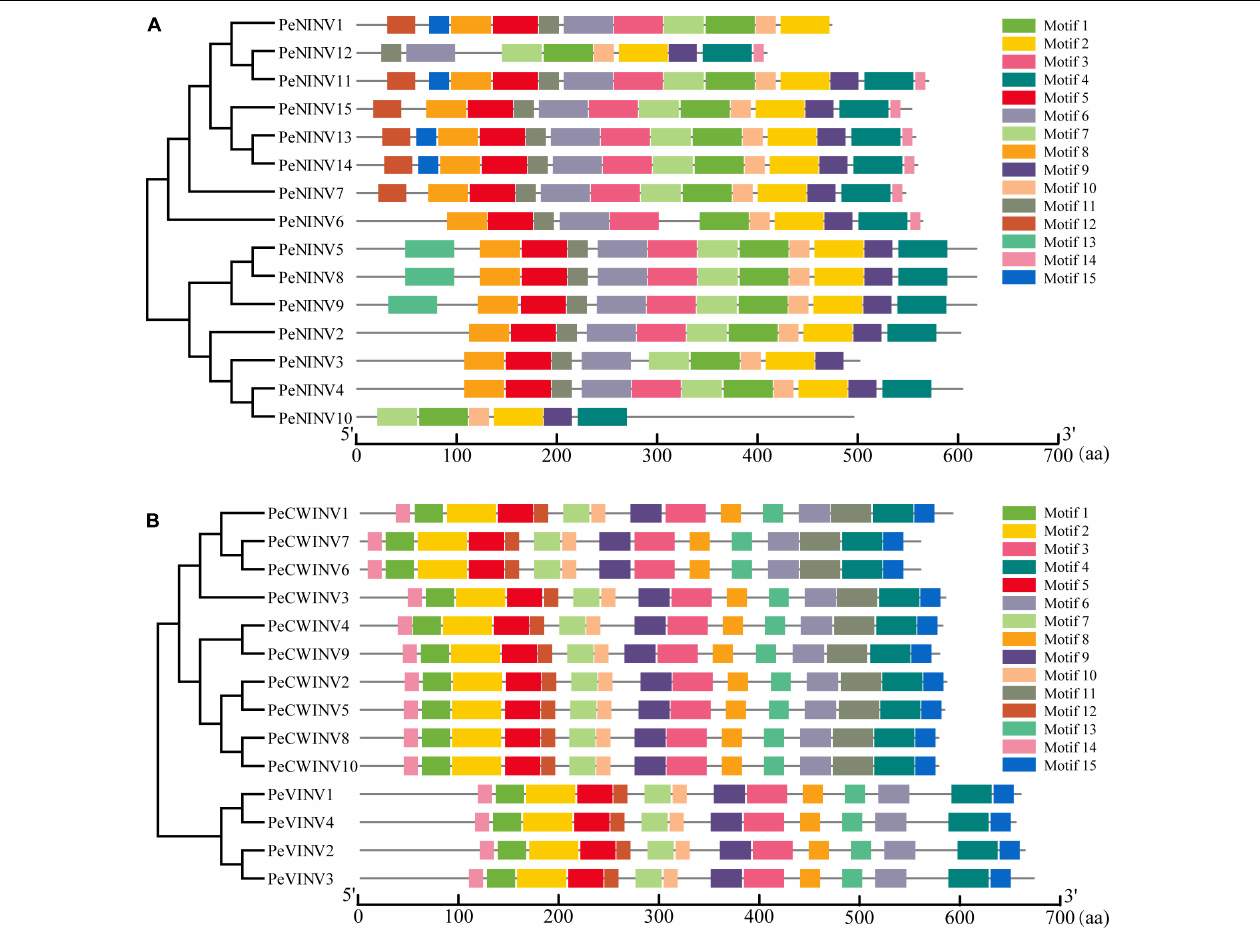
FIGURE 3 | Distribution of motifs in PeINVs. (A) Motifs in PeNINVs. (B) Motifs in PeAINVs (PeCWINVs and PeVINVs). These motifs were investigated using the MEME web server and TBtools software. The different motifs were represented by different colors.